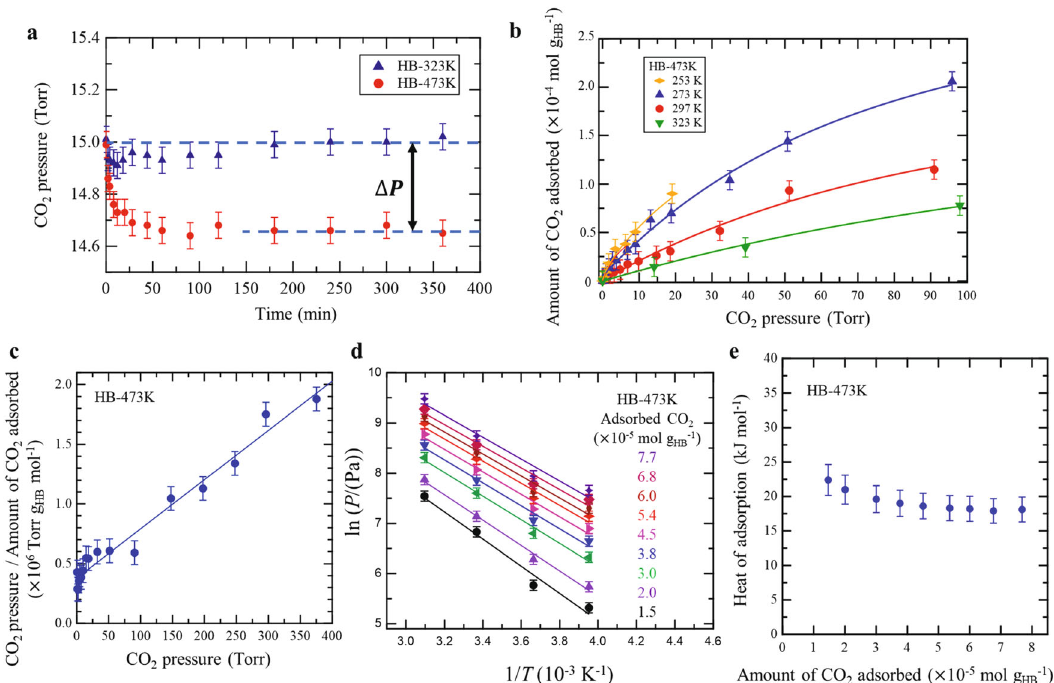
Fig. 1 CO 2 adsorption on hydrogen boride (HB) sheets. a Change in pressure of CO 2 with time following exposure to HB sheets at 297 K. Blue triangles: HB sheets preheated at 323 K for 1 h in vacuum (HB-323K). Red circles: HB sheets preheated at 473 K for 1 h in vacuum (HB-473K), at which temperature the HB sheets became hydrogen-de fi cient (H x B 1 , 0.81 < x < 0.95) due to partial decomposition and hydrogen release (see the text for details). b Isotherms of CO 2 adsorption on HB-473K. c P / n ads vs P plot for the results in b at 273 K and the results obtained at higher CO 2 pressures ( P ) of up to 400 Torr ( n ads denotes the amount of adsorbed CO 2 ). d ln( P ) vs 1/ T plot for the results in b . e Heat of adsorption as a function of the amount of adsorbed CO 2 derived from the Clausius – Clapeyron equation and slopes in b . Error bars result from the uncertainty in our measurement of